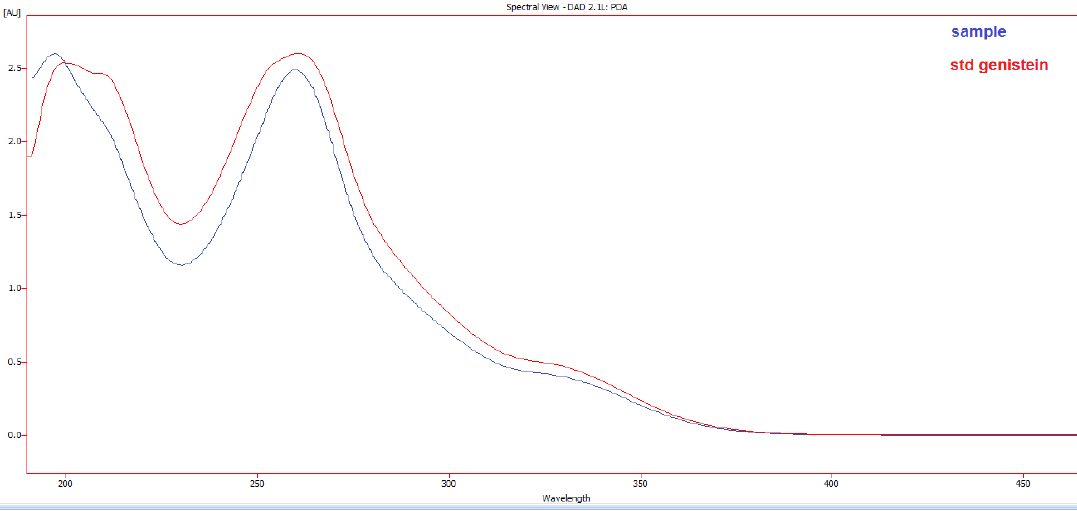
Figure 15. UV spectrum of standard genistein and isolated cpdC2 FTIR: IR spectrum of isolated cpd C2 was showed in the figure (16) and interpretation of the bands in the table (6).